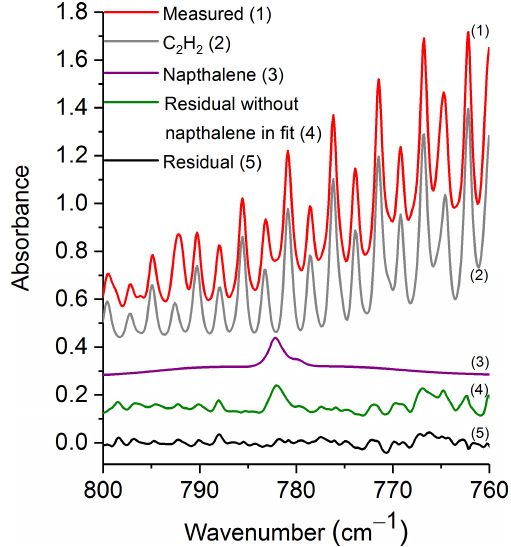
Figure 3. Measured spectrum, scaled reference spectra for C 2 H 2 and naphthalene, and residuals with and without naphthalene in- cluded in the fit. For clarity, the spectral contributions for CO 2 , HCN and H 2 O are not shown. All spectra are at 0.6cm − 1 resolution and have been offset. The calculated mixing ratio of naphthalene in this measured spectrum is